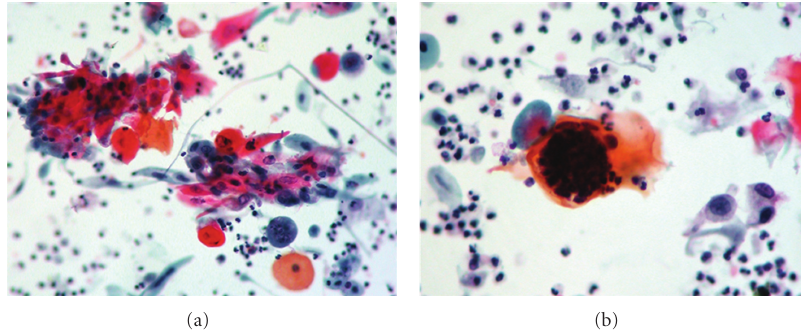
Figure 3: Urine cytology specimen showing (a) clusters of keratinised malignant squamous cells and (b) Schistosoma egg, probably with a terminally located spine.